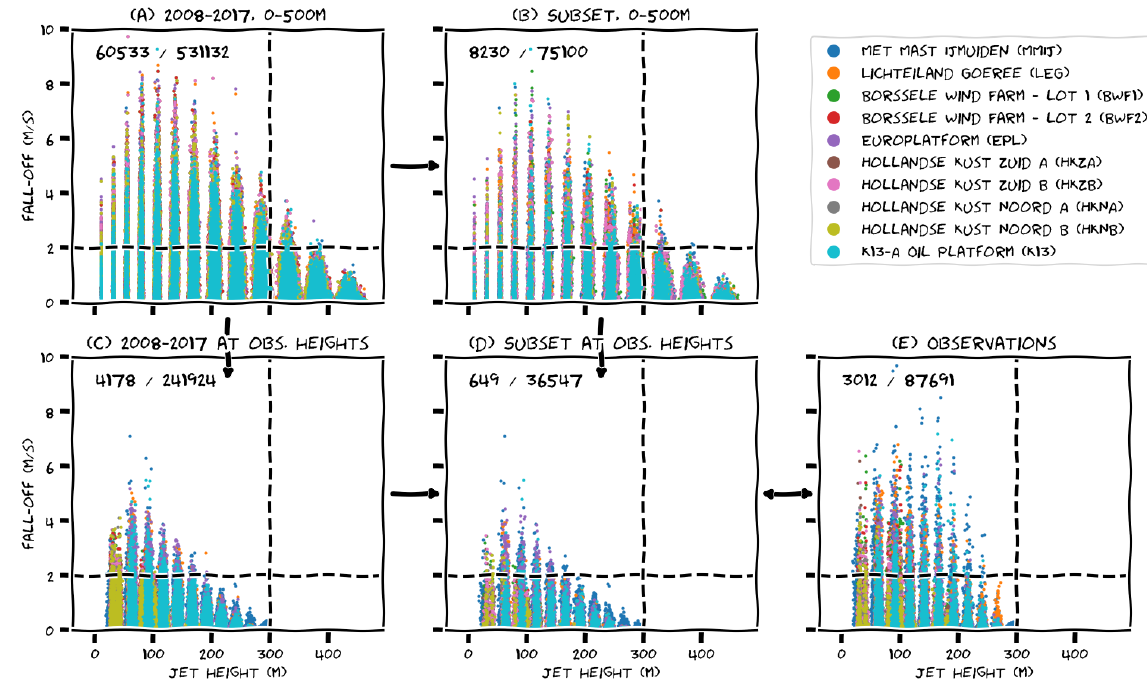
Figure 4. Scatter plots of fall-off versus jet height for various representations of model data and observations. In (a) and (b) , the jet height is represented by discrete model levels. Since these are specified in terms of pressure rather than height, they can exhibit small height variations in time. In (c) , (d) , and (e) , jet height is represented by fixed measurement heights, and to improve the readability of the graph we added small random perturbations to these heights. See text for further explanation of the